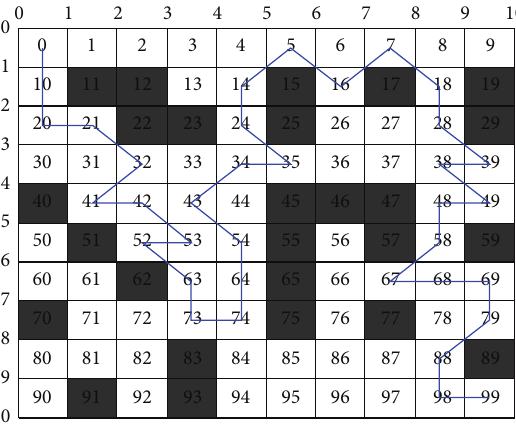
Figure 4: Route before abandoning